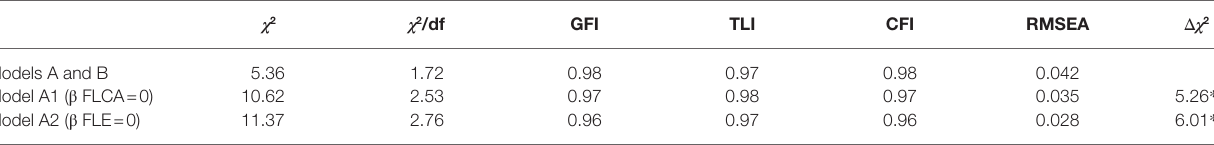
TABLE 4 | Goodness of fit